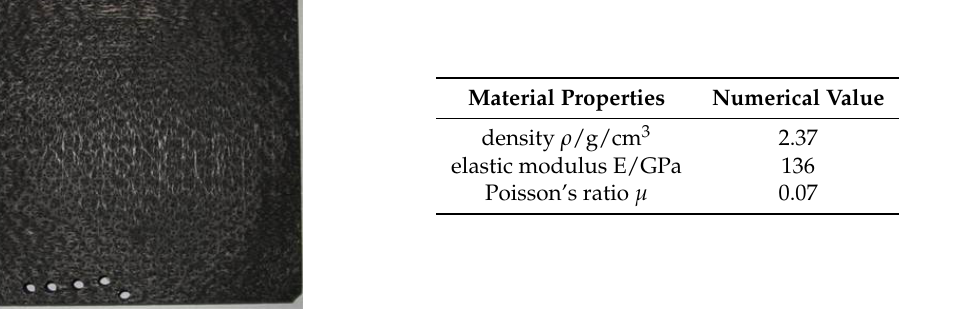
Figure 1. C/SiC test piece and its material properties.